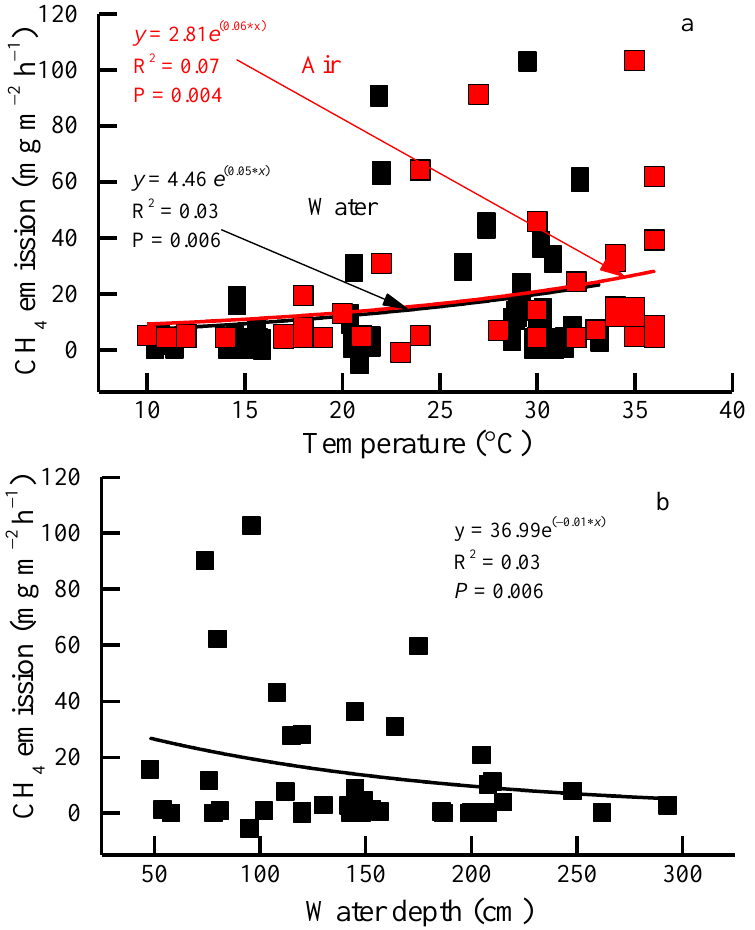
Figure 6. The correlation between CH 4 emissions, temperature (air and water) and water depth.